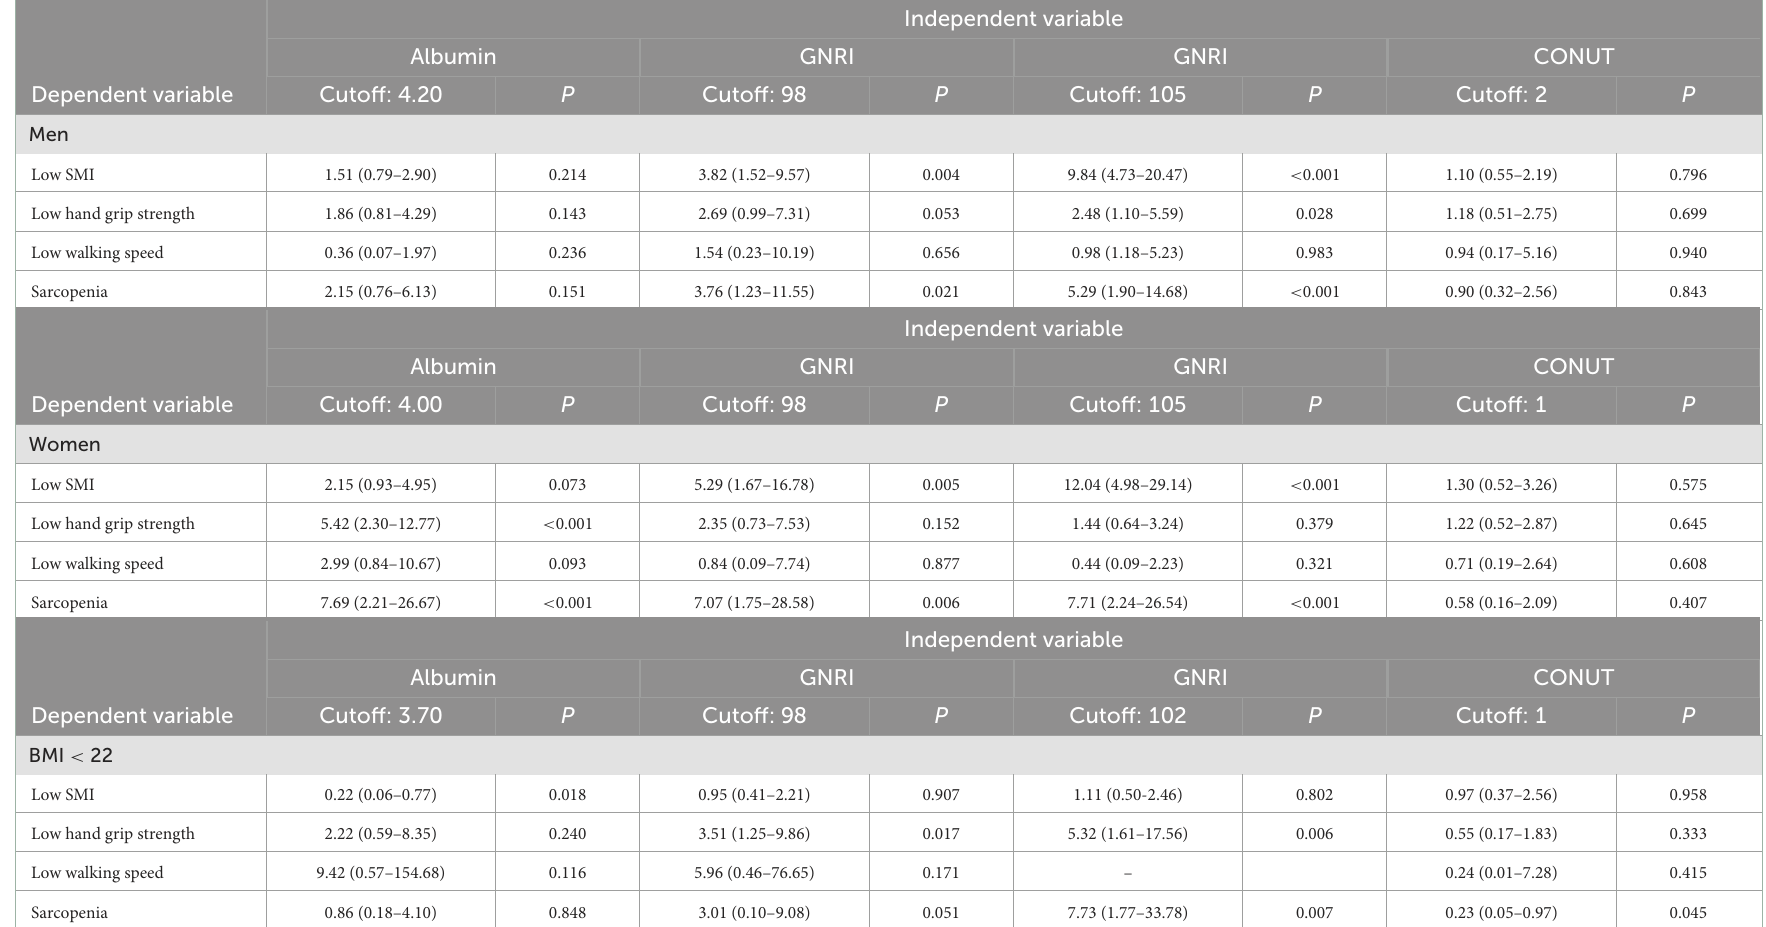
TABLE 5 Multivariate logistic regression analysis (Model 2 in Table 4) on associations of cutoff of nutritional indices with diagnosis of